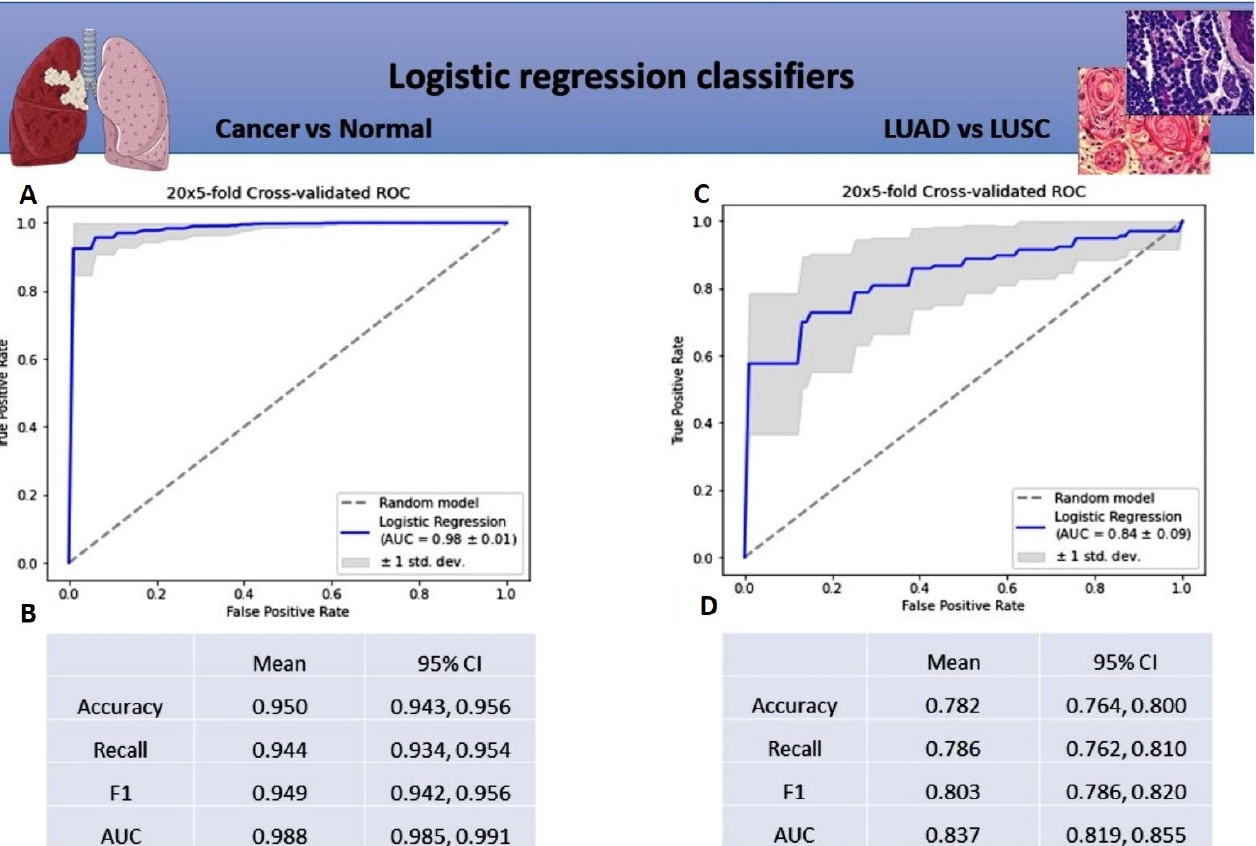
Figure 2. Metrics for logistic regression classifier for differentiating normal tissue from tumor tissue and LUSC tissue from LUAD tissue: ( A ) Mean ROC ± SD curve, and AUC for logistic regression classifier for differentiating normal tissue from cancer tissue; ( B ) Mean and 95% CI for precision, recall, f1-score, and AUC metrics for logistic regression classifier for differentiating normal tissue from cancer tissue; ( C ) Mean ROC ± SD curve, and mean AUC for logistic regression classifier for differentiating LUSC tissue from LUAD tissue; ( D ) Mean and 95% CI of precision, recall, f1-score metrics, and AUC for logistic regression classifier for differentiating LUSC tissue from LUAD tissue.